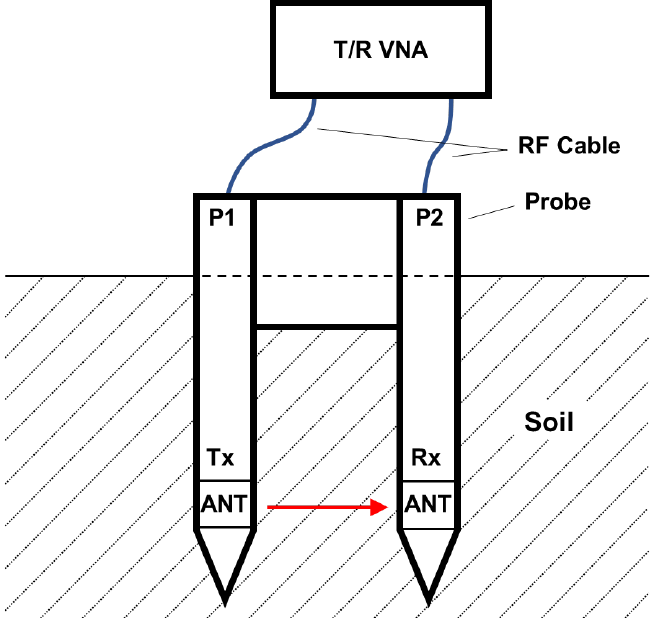
Figure 1. Schematic illustration of the SFDT sensor. Port 1 and Port 2 are expressed as P1 and P2, and the antenna is expressed as ANT.